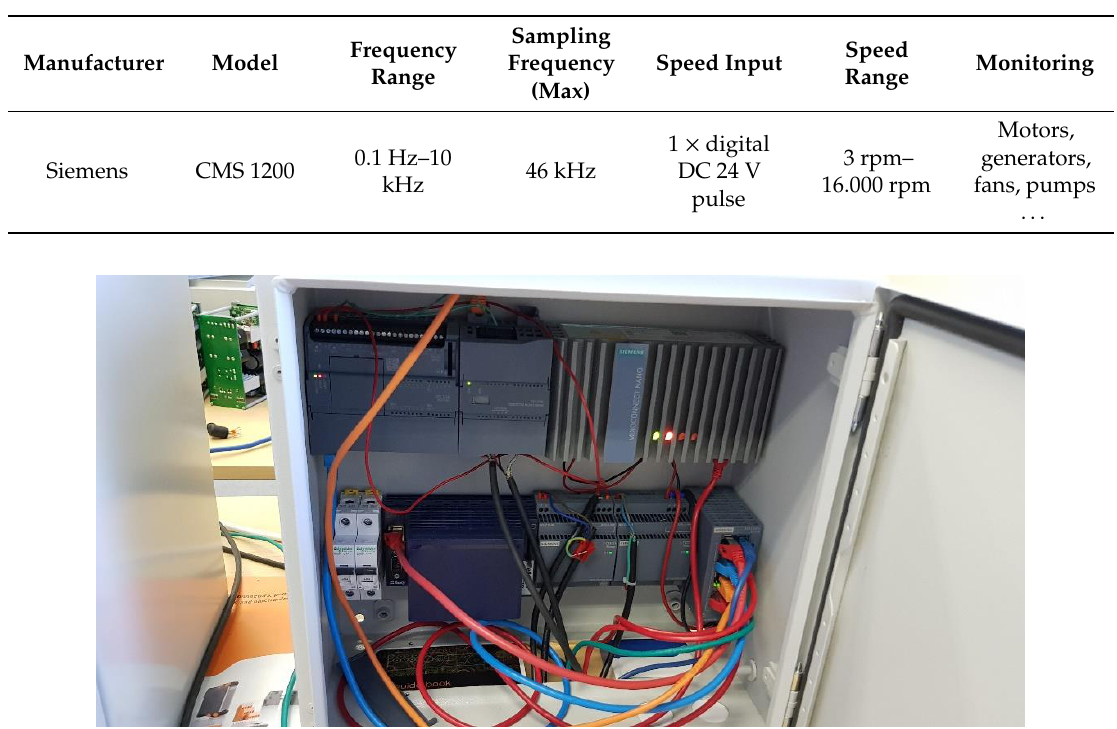
Figure 2. Data acquisition devices.